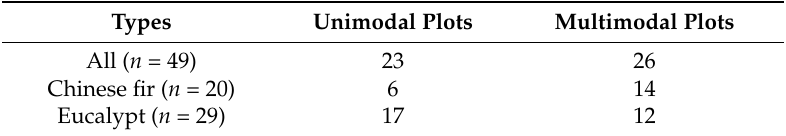
The results of classified plots using bimodality coefficient for reference measured diameter distributions. Types Unimodal Plots Multimodal